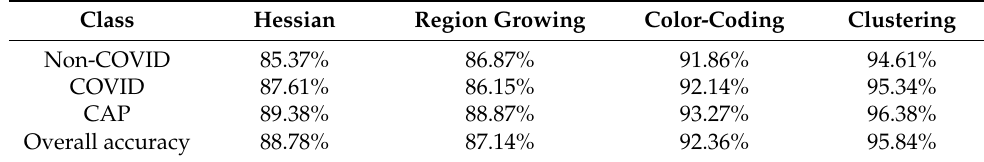
Table 4. Class-based accuracy of all methods with